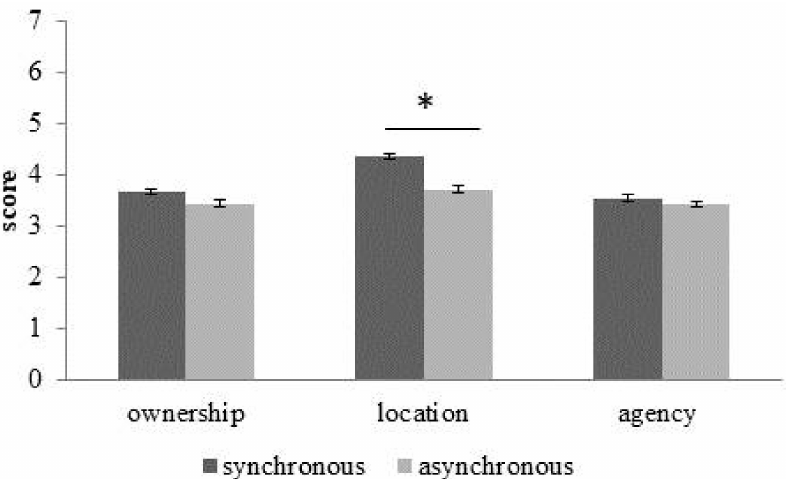
Figure 2. About the Embodiment questionnaire, means of the score and standard error (bars) were showed for each subscale (ownership, location and agency) in the synchronous (dark grey) and asynchronous (light grey) conditions. * indicates a significant di ff erence according to the Bonferroni-corrected p value of